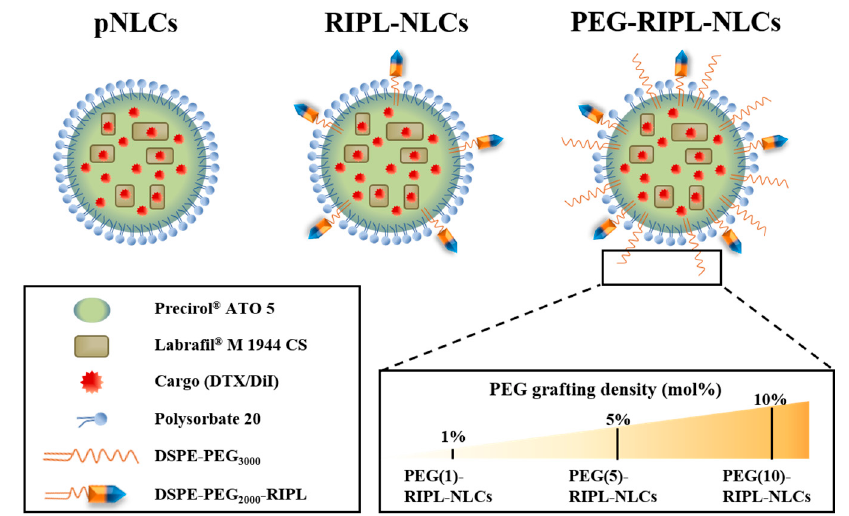
Figure 1. Conformational comparison of different nanostructured lipid carriers (NLCs).